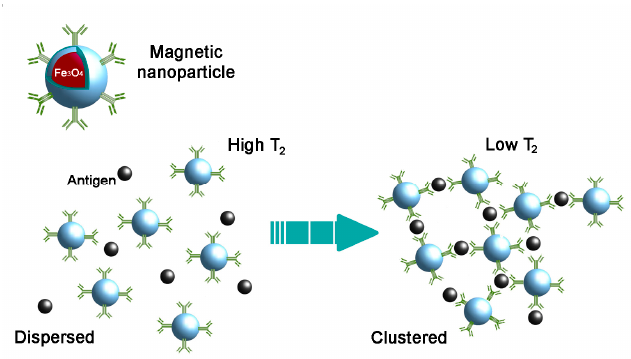
Figure 2. Schematic representation of magnetic nanoparticle (MNP) clustering in the presence of a specific antigen. Following interaction between functionalized MNPs and an antigen, the clustering of MNPs induces a change in the T 2 relaxation values of the surrounding water molecules, which can be detected by (diagnostic) magnetic resonance.